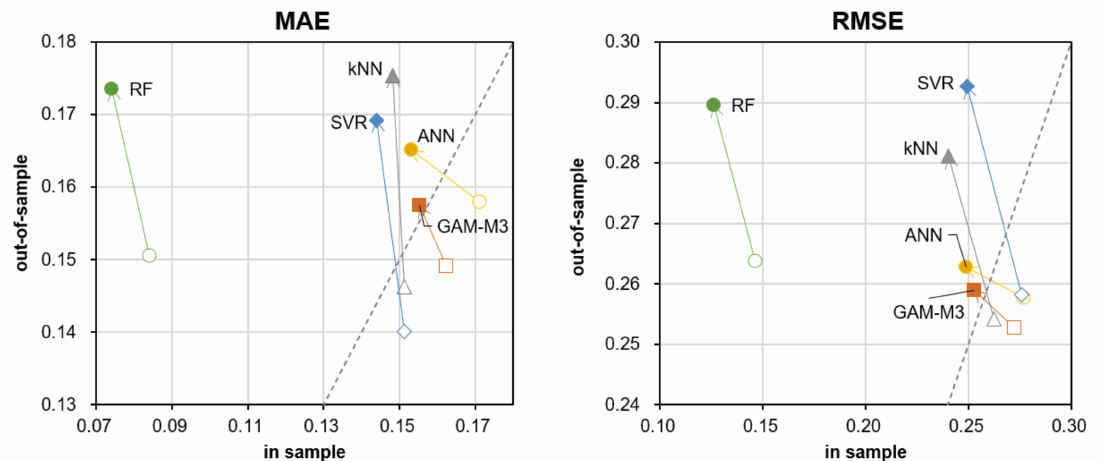
Figure 8. MAE and RMSE of each method on individual PV power generation (change in forecast error by method when the in-sample period is shortened). Note: White dots represent the 5-year in-sample period (corresponding to values in Table 2), and color-filled dots represent the 9-month in-sample period. Out-samples were both 2018 (i.e., this is “Additional validation case 1” in Figure